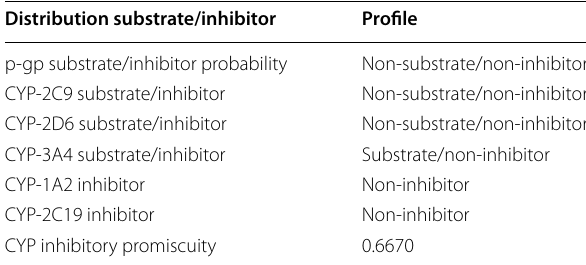
Table 4 In silico distribution profile of hesperidin as obtained from the AdmetSar